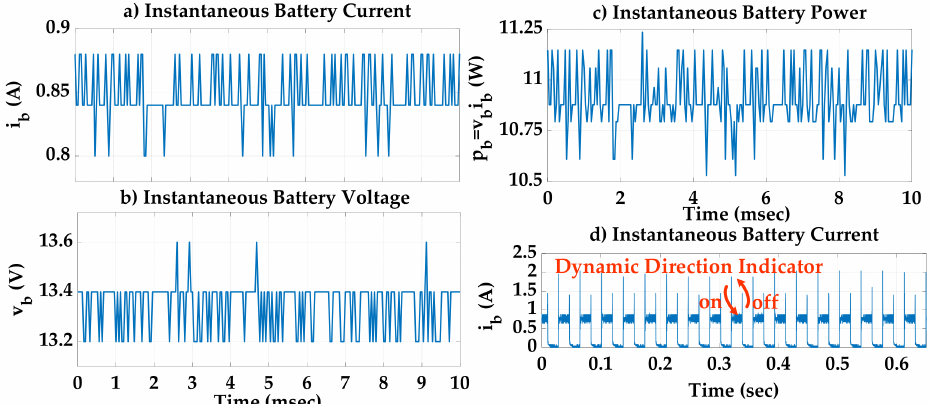
Figure 9. Real-time results regarding the novel industrial prototype incorporated in the 6-Function rear LED lamp under real conditions performance test; ( a ) instantaneous battery current under continuous function, ( b ) instantaneous battery voltage under continuous function, ( c ) instantaneous battery recycled power under continuous function, and ( d ) instantaneous battery current under dynamic direction indicator function.